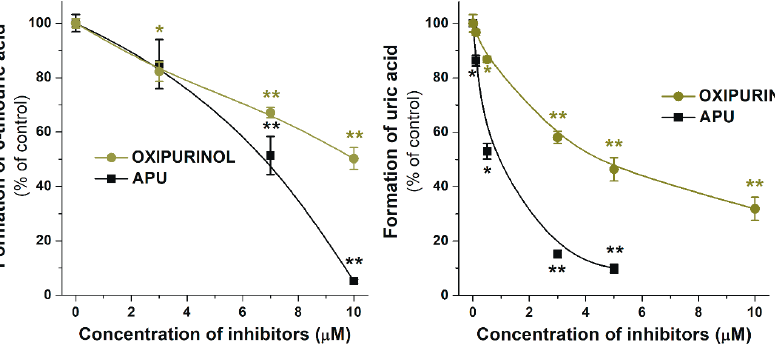
Figure 3. Inhibitory effects of Q and its conjugated metabolites on XO-catalyzed oxidation of 6-MP (5 Figure 4. Inhibitory effects of oxipurinol and allopurinol (APU) on XO-catalyzed oxidation of 6-MP μ M) after 40 min incubation, in the presence of increasing concentrations of allopurinol (APU), and xanthine after 40 and 8 min incubations, respectively. * p < 0.05; ** p < 0.01). quercetin (Q), isorhamnetin (IR), tamarixetin (TAM), quercetin-3 ′ -sulfate (Q3 ′ S), quercetin-3- glucuronide (Q3G), and isorhamnetin-3-glucuronide (I3G). The 50% inhibition of 6-thiouric acid Table 1. Inhibition of XO-catalyzed 6-TU formation and uric acid formation by APU, Q, Q3 ′ S, IR, formation (IC 50 ) is marked with dashed line (* p < 0.05; ** p < 0.01). TAM, Q3G, I3G, and PYR. IC 50 : concentration of the compound which induces 50% inhibition of metabolite formation, IC 50(rel) = IC 50 of the inhibitor divided by the substrate concentration (5 μ M 6- MP), α = IC 50 of the inhibitor divided by IC 50 of the positive control.